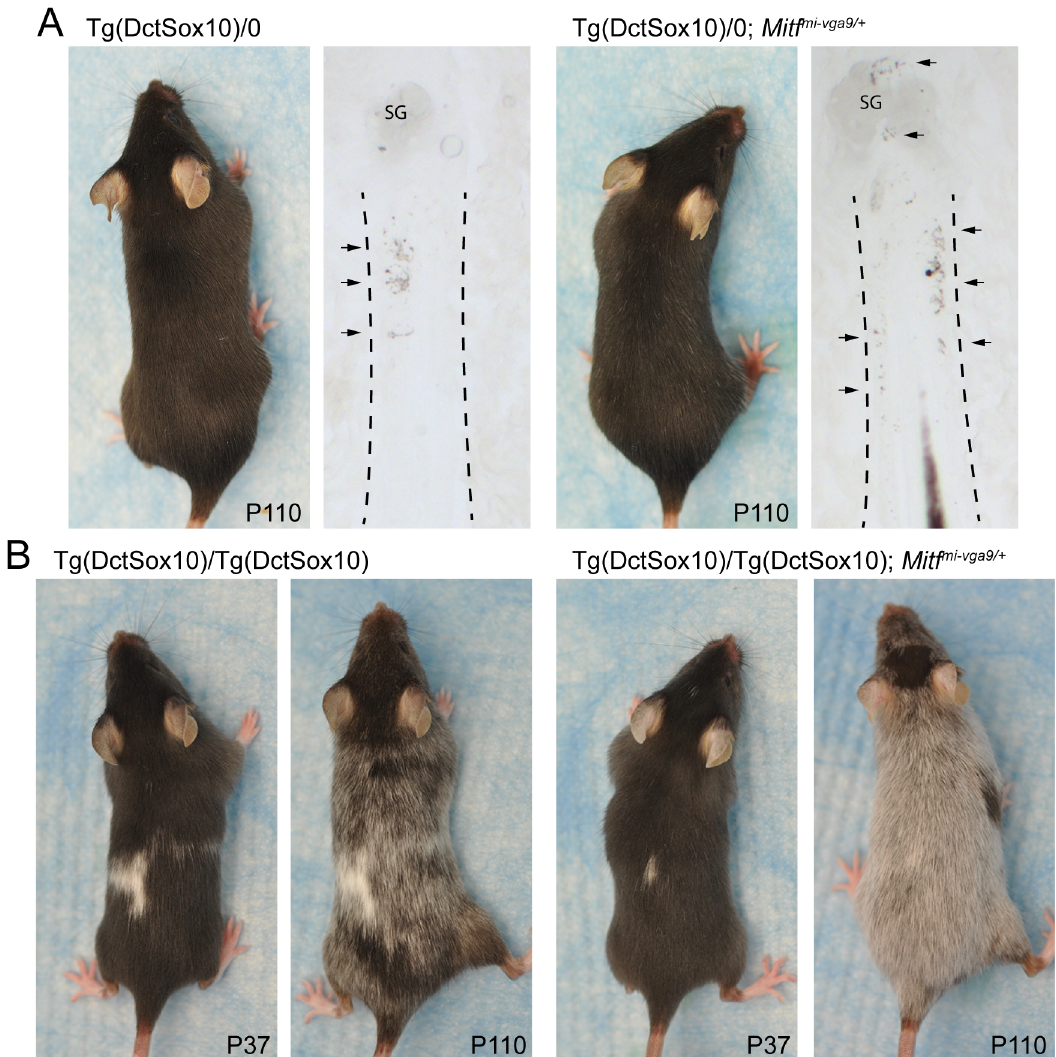
Fig 1. Increased hair graying and McSC differentiation occurs in Tg(Dct-Sox10) animals that are haploinsufficient for Mitf mi-vga9/+ . (A) Dorsal images of two female littermates taken at P110. At this age, the coat of Tg(Dct-Sox10)/0 mice appears solid black, while the coat of Tg(Dct-Sox10)/0; Mitf mi-vga9/+ mice exhibits a small number of gray hairs along its back. Bright- field images of histological sections of the skins from these mice reveal increased ectopic pigmentation (arrows) within the hair bulge (region between the dotted lines) of hairs from Tg(Dct-Sox10)/0; Mitf mi-vga9/+ animals in comparison to Tg(Dct-Sox10)/0 animals. (B) Dorsal images of two female littermates taken at P37 and P110. At P37, Tg(Dct-Sox10)/Tg(Dct-Sox10) mice exhibit a black coat with congenital white spotting on the belly and back. These mice experience progressive hair graying and by P110 exhibit a “salt and pepper” coat color in regions of the back fur that were originally black. In comparison to Tg(Dct- Sox10)/Tg(Dct-Sox10) mice, hair graying in Tg(Dct-Sox10)/Tg(Dct-Sox10); Mitf mi-vga9/+ mice at P110 is more severe, with a majority of the back fur exhibiting gray hairs. The images for this figure were generated in the original study presented in [17]. McSC, melanocyte stem cell; P, postnatal day; SG, sebaceous gland.